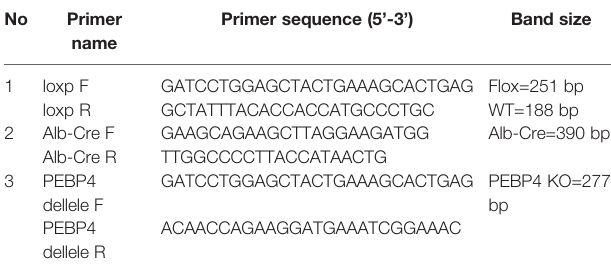
TABLE 1 | Sequence used for